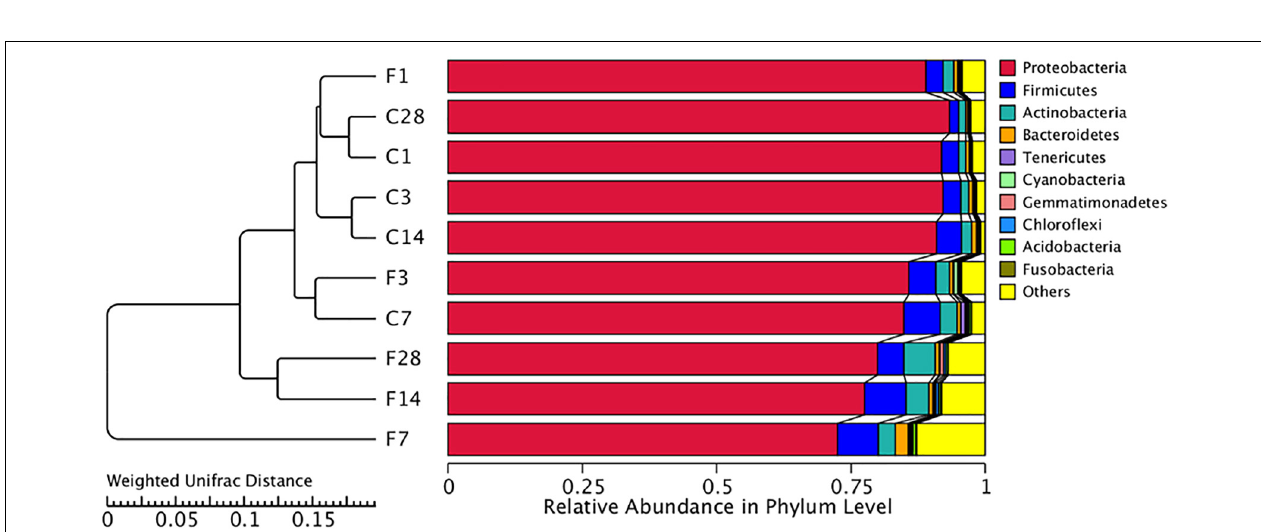
FIGURE 4 | Unweighted pair-group method with arithmetic mean (UPGMA) cluster tree based on weighted uniFrac distance (left) and the relative abundance profiles of species at the phylum level (right). The majority of the OTUs were dominated by ten phyla: Proteobacteria , Firmicutes , Actinobacteria , Tenericutes , Cyanobacteria , Gemmatimonadetes , Chloroflexi , Acidobacteria, and Fusobacteria . Based on the weighted uniFrac distance, the microbiome of LTR treated with influenza virus at the 7, 14, and 28 dpi are similar, and far different from saline-treated group. C, the group treated with saline; F, the group treated with influenza virus; the number followed C/F represented the day post